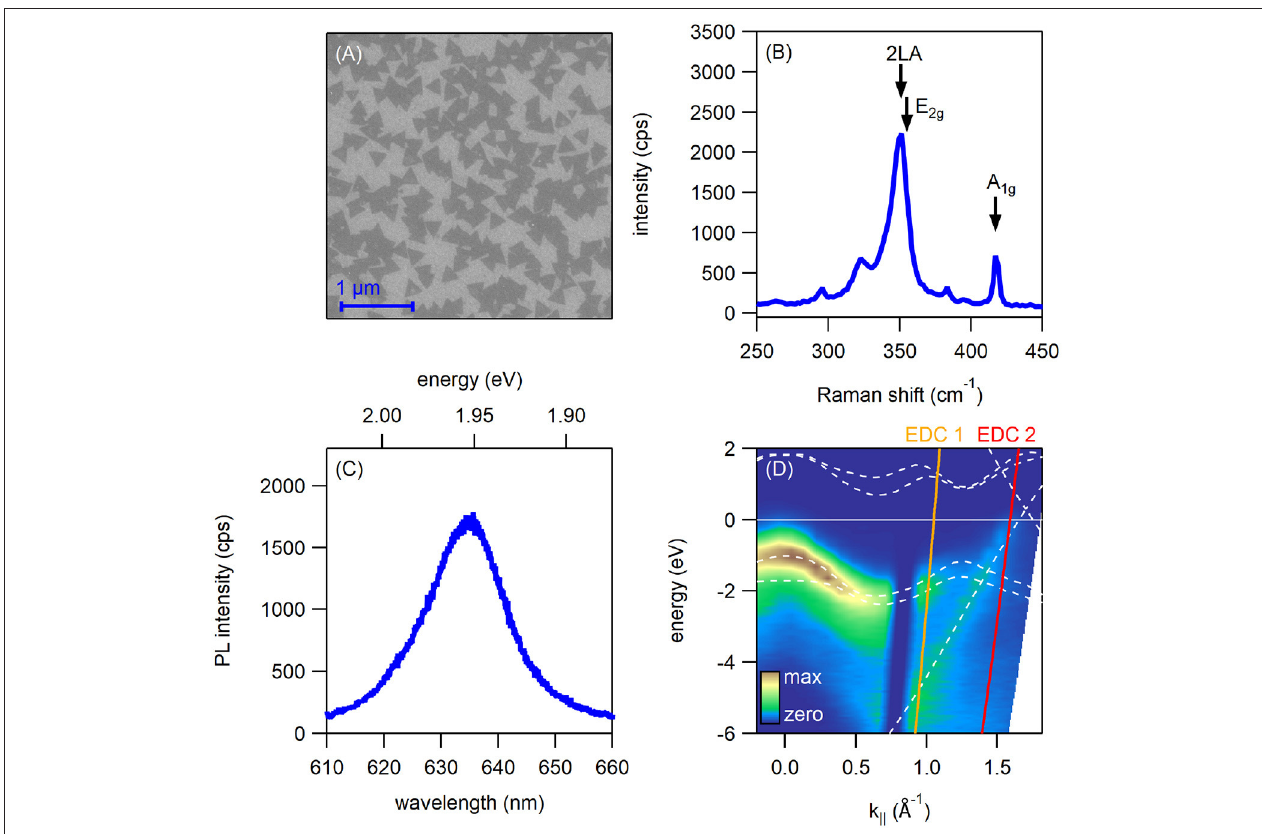
FIGURE 2 | Sample characterization: (A) Secondary electron micrograph revealing triangular WS 2 islands with two different rotational domains. The picture was obtained with in lens mode with an accelerating voltage of 5keV and a beam current of 96pA. (B) Raman spectrum. Arrows indicate the phonon modes that were used to determine the layer thickness. (C) Photoluminescence (PL) spectrum. Raman and PL measurements were carried out with 1mW laser excitation at λ = 532nm at room temperature. (D) ARPES spectrum revealing the occupied part of the band structure of the heterostructure. Orange and red lines indicate the two energy distribution curves (EDCs) that were chosen for the time-resolved measurements in Figure 3 . White dashed lines denote theoretical band positions of graphene [27] and bilayer WS 2 [15]. A rigid band shift of +0.3eV was applied to graphene bands to account for the observed p-doping. WS 2 CB and VB were rigidly shifted by − 0.81 and − 1.19eV, respectively, to match the experimental dispersion. The thin white line marks the position of the Fermi level, E F . At an emission angle of ∼ 23 ◦ the laser beam was directly reflected into the Time-of-Flight analyzer dazzling the detector and leading to a dark corridor at ∼ 0.8Å − 1